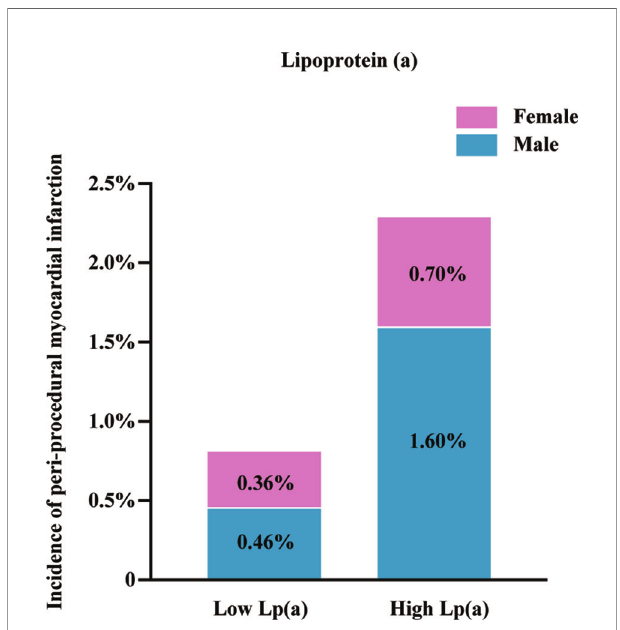
FIGURE 1 | Incidence of peri-procedural myocardial infarction. Lp(a), lipoprotein(a); high Lp(a), Lp(a) > 175 mg/L.